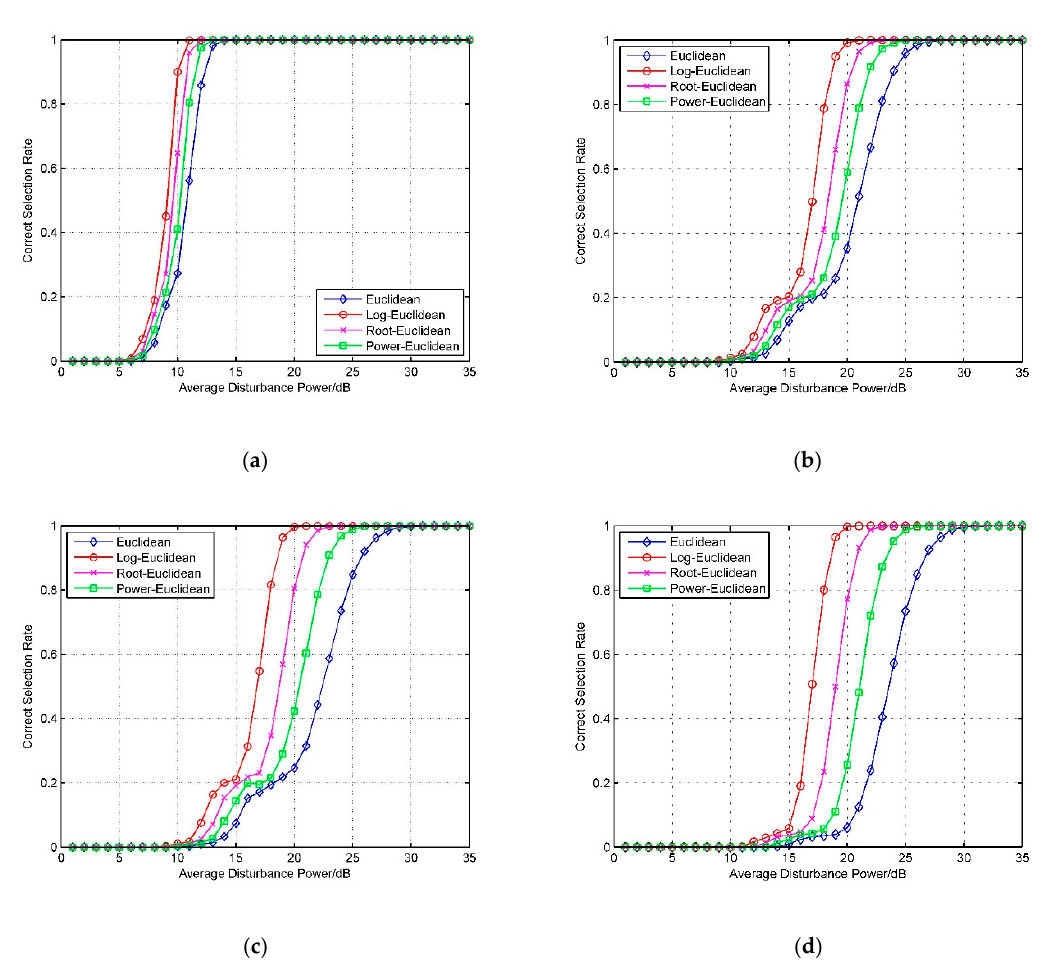
Figure5. Correctselectionrateagainstaveragedisturbancepowerwithdi ff erentnormalizeddisturbance Figure 5. Correct selection rate against average disturbance power with different normalized Doppler frequency. N = 8, K = 100, Ω = 30, σ 2 c = 15 dB, ρ = 0.95, f d disturbance Doppler frequency. number of MC are 5000; ( a ) { 0.30 ± 0.01 } ; ( c )